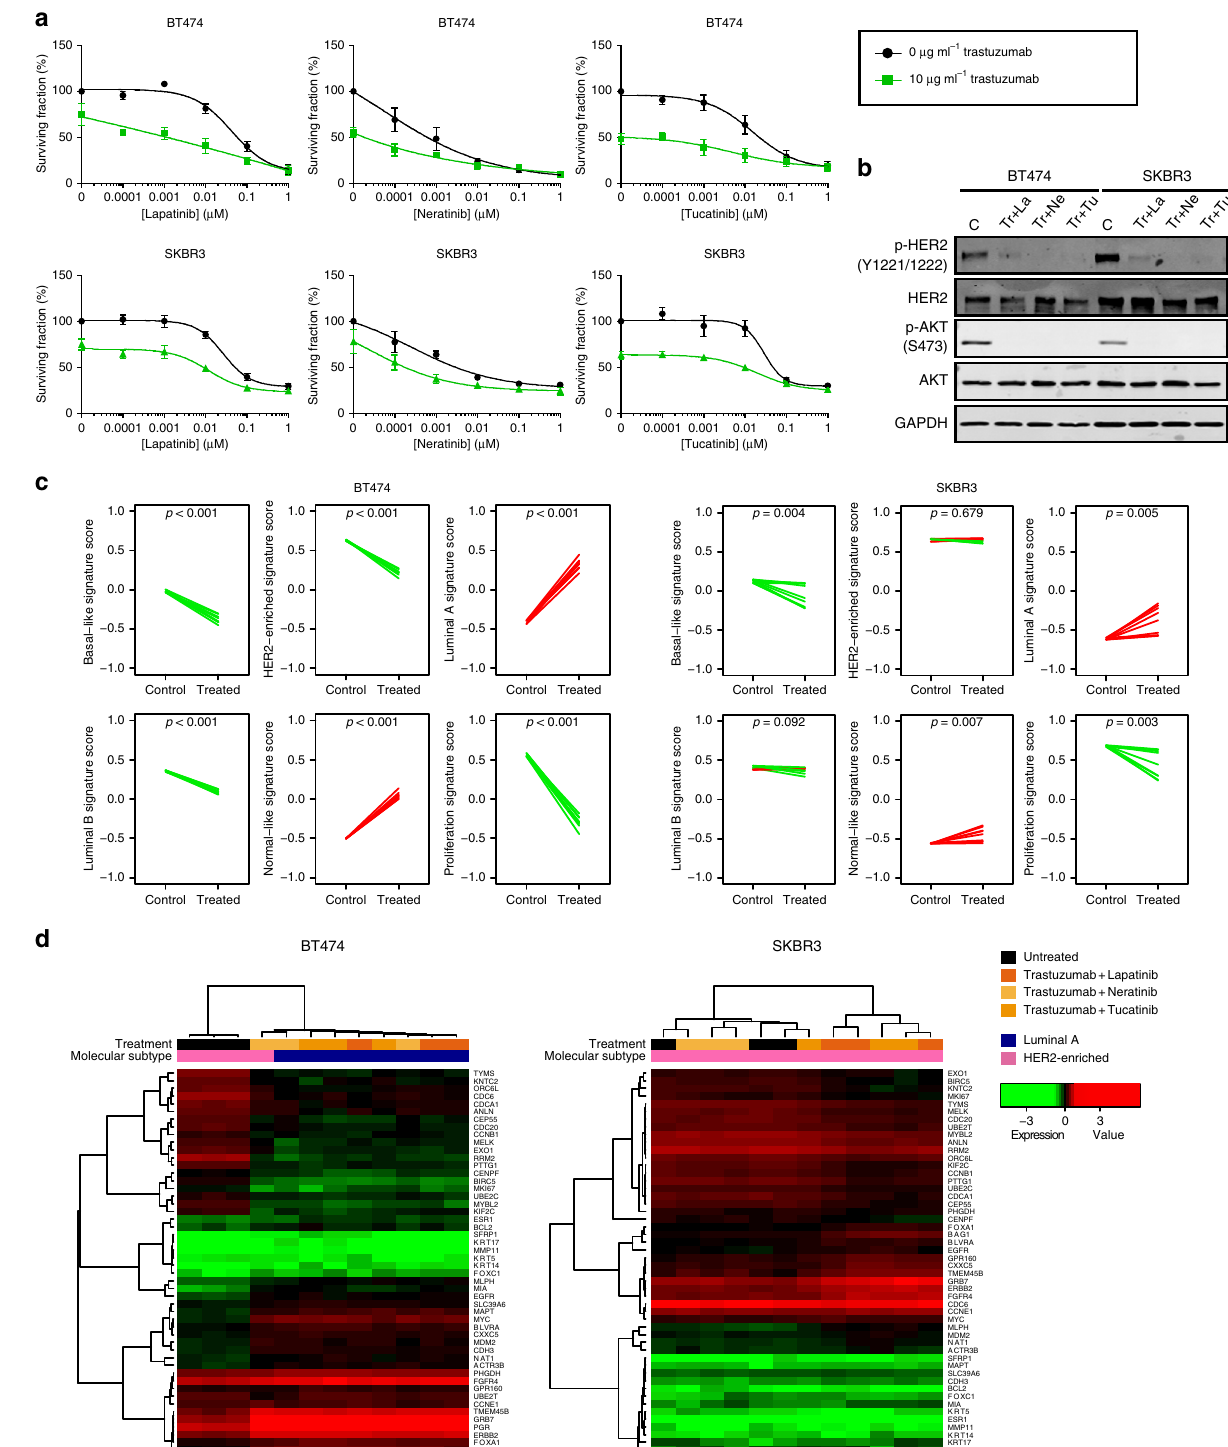
Fig. 2 Effects of anti-HER2 treatments in HER2-E breast cancer cell lines. a Cell viability (%) of BT474 and SKBR3 cells upon treatment with increasing concentrations of the TKI lapatinib, neratinib or tucatinib as monotherapy or in combination with 10 µ g ml − 1 trastuzumab for 72 h. Data points represent the mean; error bars represent the standard error of the mean of 3 independent experiments. b Phosphorylation and total levels of HER2 and AKT upon 24h of treatment with 10 µ g ml − 1 trastuzumab plus TKI (10 nM lapatinib, 10nM neratinib, 10nM tucatinib) as assessed by Western Blot. c PAM50 signature scores in BT474 and SKBR3 cells untreated and treated with combinations of TKI and trastuzumab for 72h. Each line represents a paired sample. Increases are represented in red and decreases in green. P -values ( p ) were determined by two-tailed paired t -tests. d Unsupervised hierarchical clustering using the PAM50 genes across BT474 and SKBR3 cells treated with combinations of TKI and trastuzumab for 72h. The heatmaps show high (red) to low (green) expression of mRNAs in each sample. The molecular subtype call and treatment of each sample is shown. Source data are provided as a Source Data fi